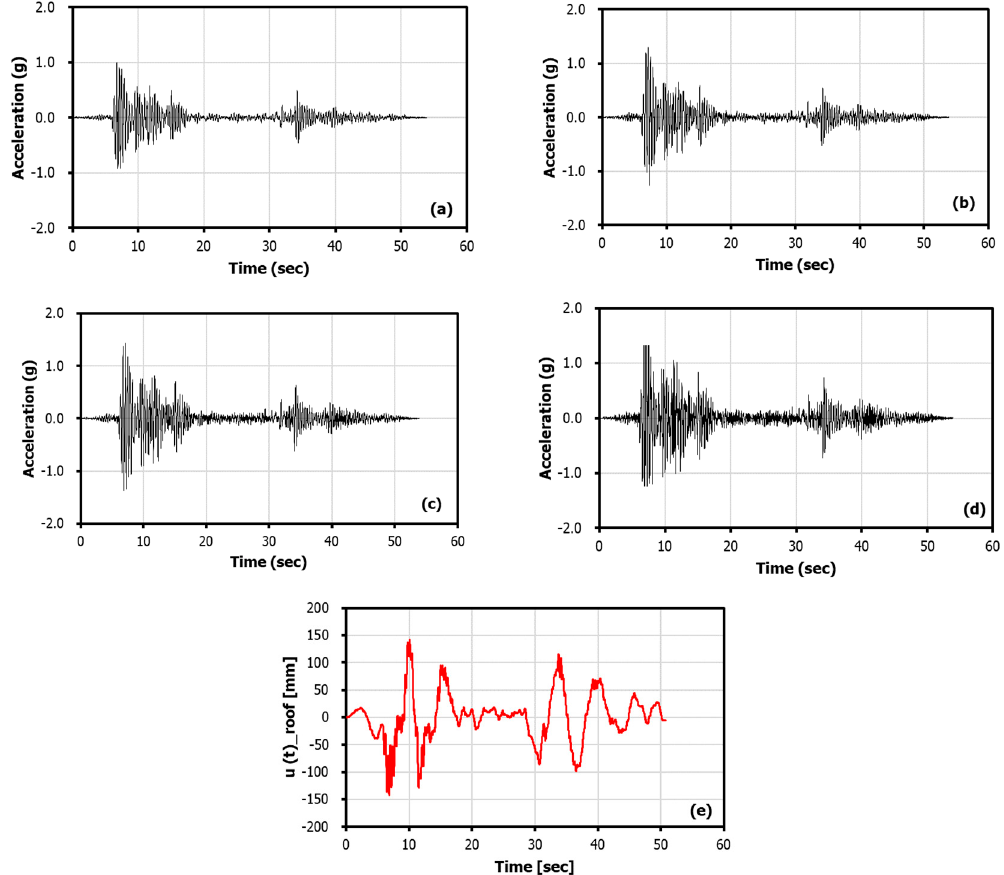
Figure 9. Dynamic response and roof displacement of the model for the Manjil earthquake; ( a ) base acceleration, ( b ) 4th floor acceleration, ( c ) 7th floor acceleration, ( d ) roof acceleration, and ( e ) roof displacement.